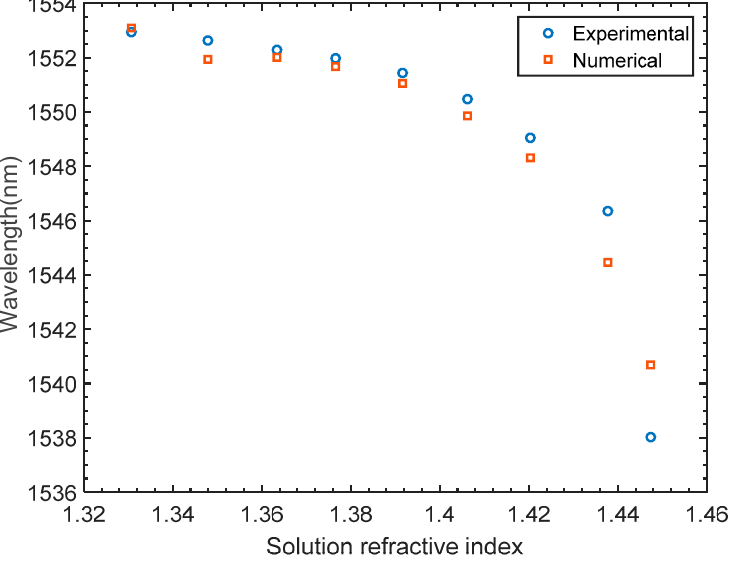
Figure 15. Numerical vs. experimental refractive index characterization of an LPFG sensor.